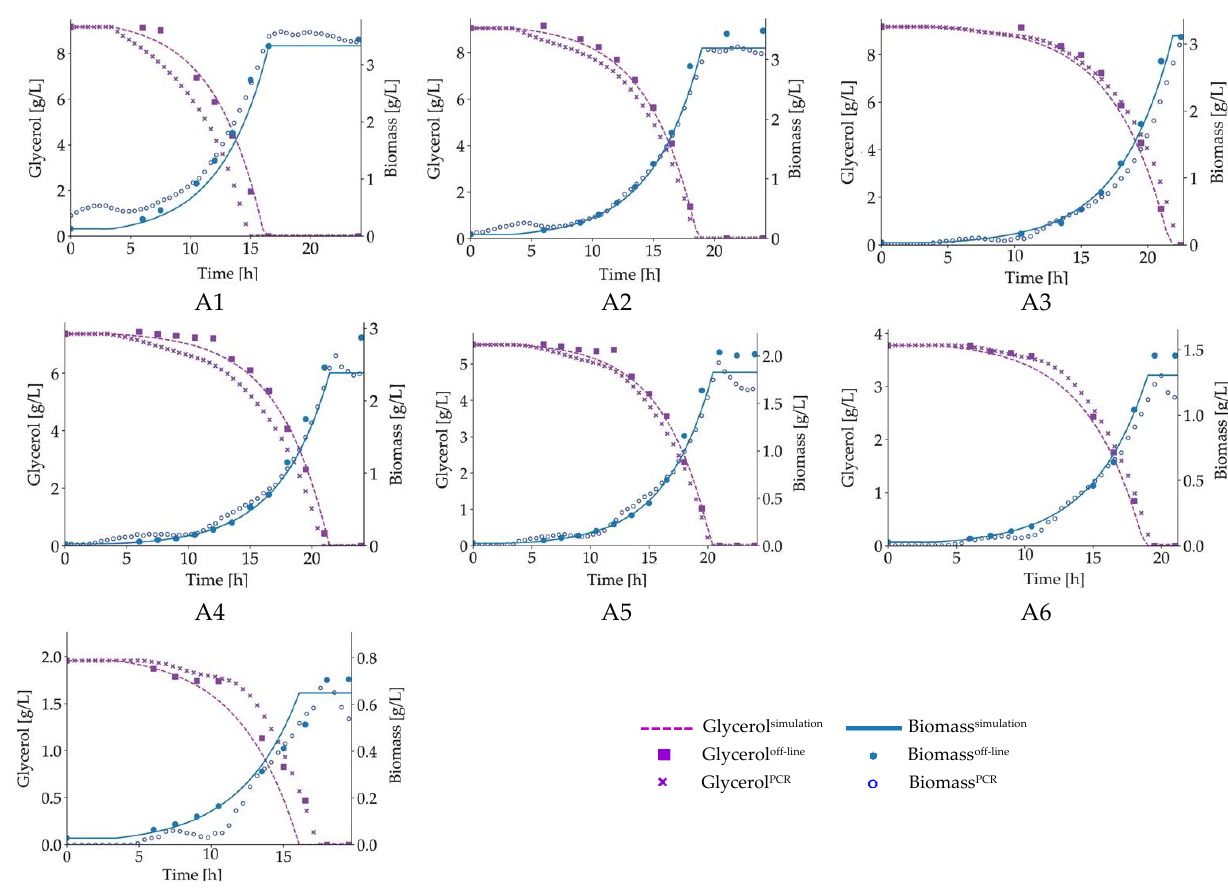
Figure 5. Offline measurements from seven cultivations ( A1 – A7 ) are presented along with the chemometric model prediction of biomass and the process model estimation of glycerol according to the IMBC.